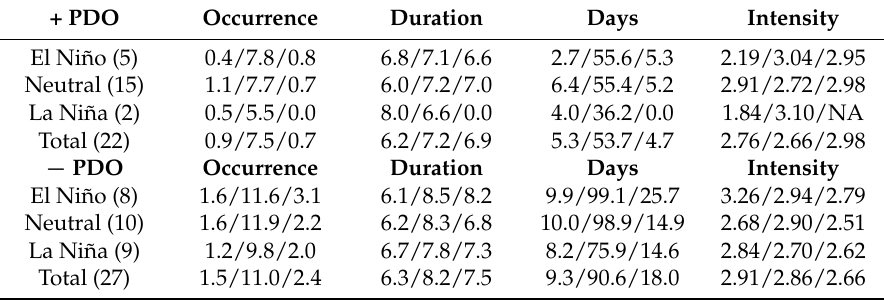
Table 8. As in Table 5, except for SH blocking events.